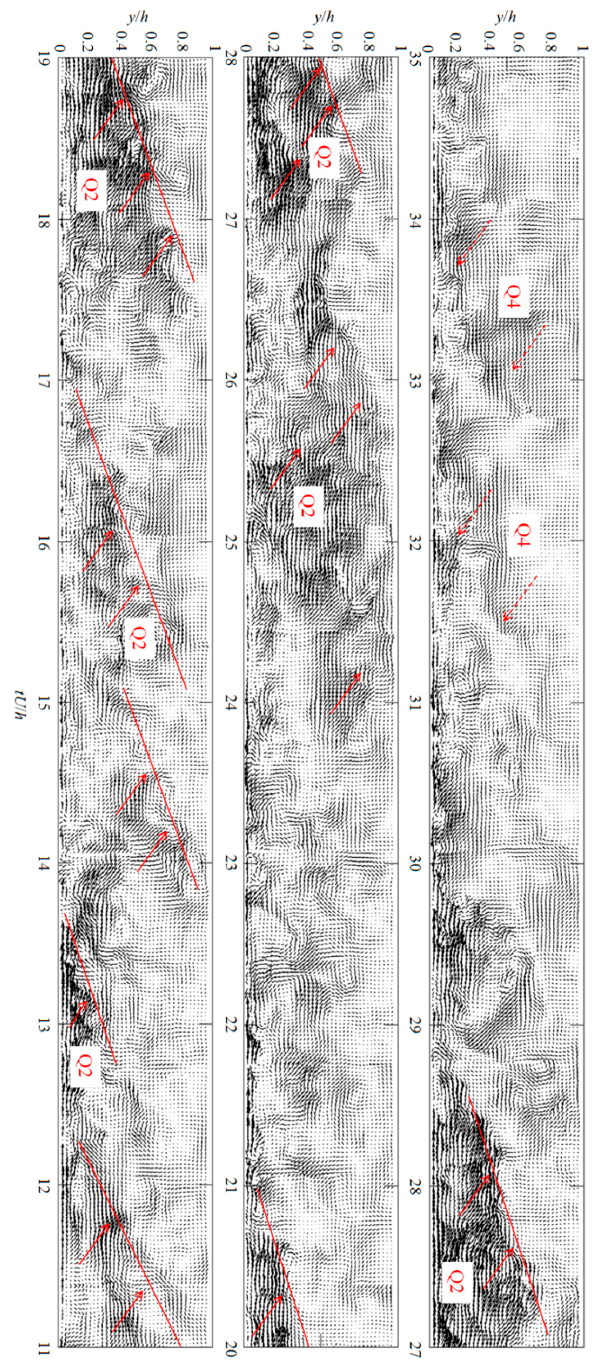
Figure 2. Fluctuating velocity fields pieced together based on Taylor’s frozen turbulence hypothesis. The red arrows indicate the strong Q2 and Q4 events in the flow field, and the red solid lines indicate the inclined shear layers.